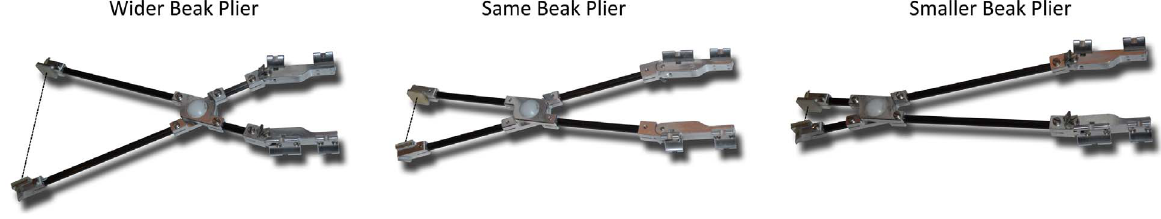
Figure 1. The three pairs of pliers. Note that for each pair of pliers depicted the opening at the digit side (i.e., right side) is kept the same in each